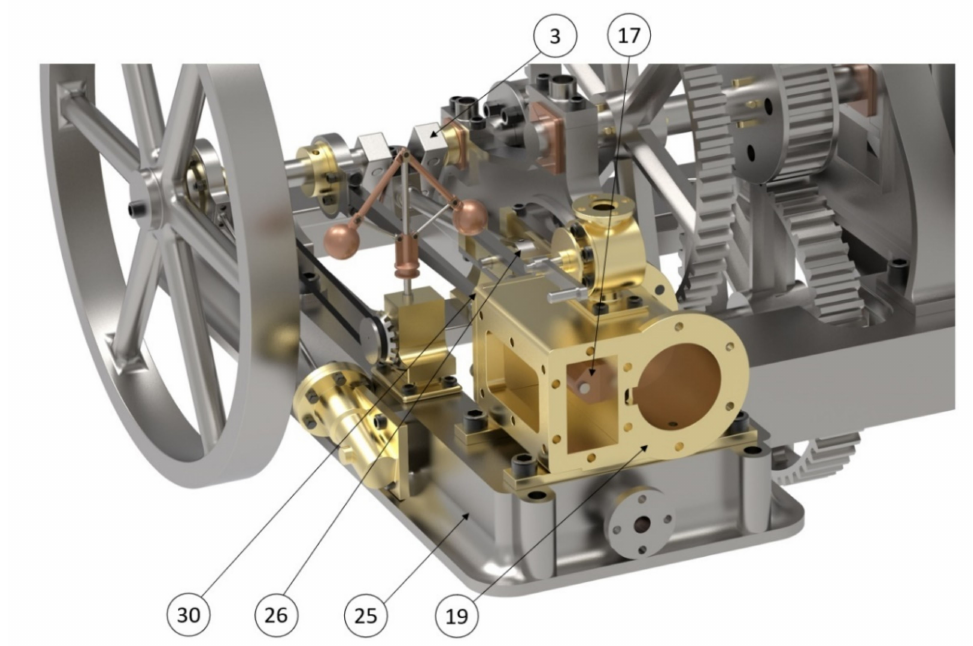
Figure 5. View of the steam engine without the steam-chamber side